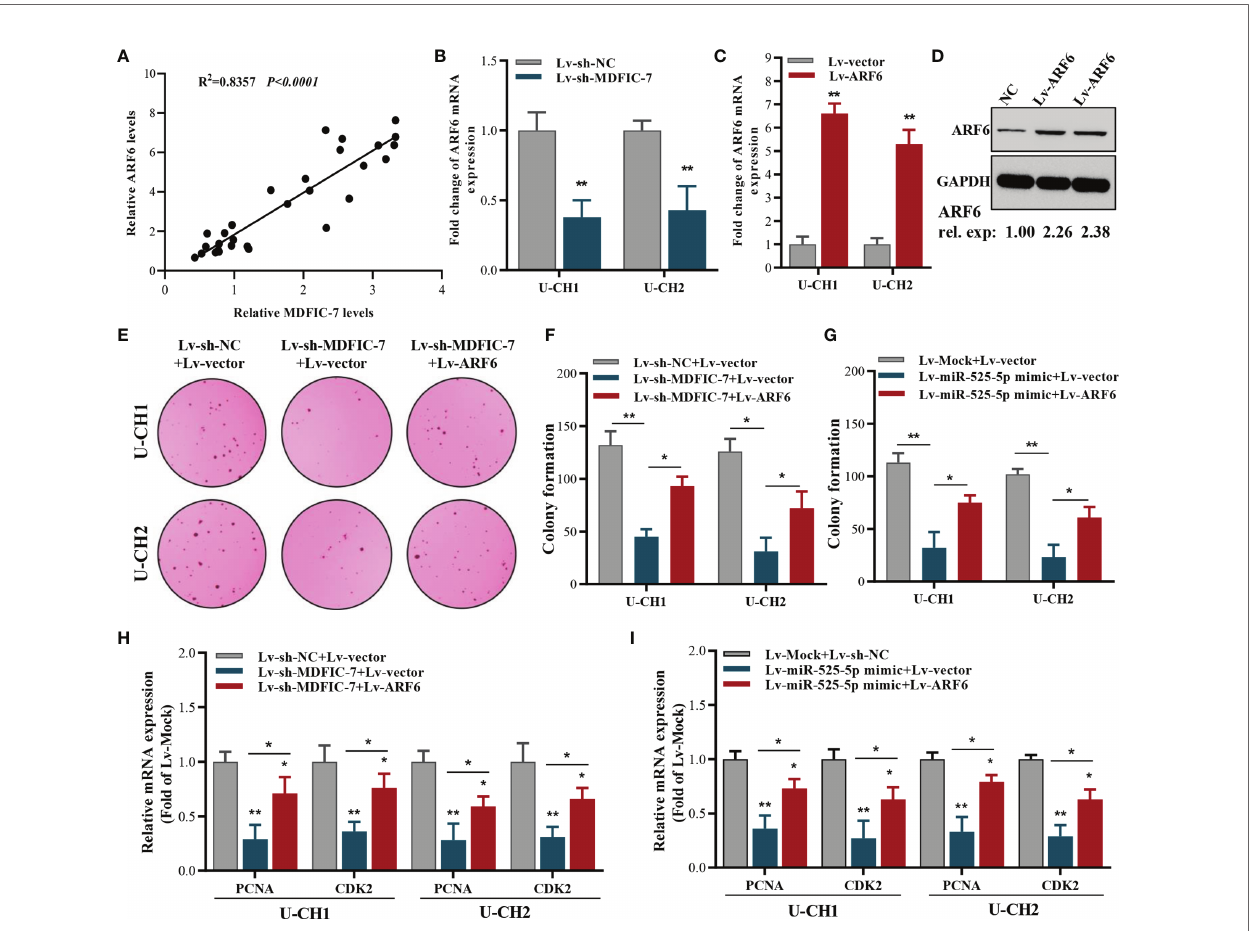
FIGURE 5 | ARF6 overexpression reverses the suppressive effect of lncRNA MDFIC-7 knockdown or miR-525-5p overexpression on cancer cell proliferation. (A) Correlation analysis between ARF6 and Ki-67 expression in tumor tissues and adjacent normal tissues of chordoma patients determined by qRT-PCR assay. (B) qRT-PCR analysis on ARF6 mRNA expression in cancer cells after lncRNA-MDFIC7 knockdown. (C, D) Effect of ARF6 mRNA and protein overexpression in U-CH1 and U-CH2 cells as detected by qRT-PCR and Western blot, respectively. (E, F) Colony formation assay in U-CH1 and U-CH2 cells after infection with Lv-sh-MDFIC-7 or co-infection with Lv-sh-MDFIC-7 and Lv-ARF6. * p < 0.05 vs . Lv-miR-lncRNA MDFIC-7+Lv-vector, ** p < 0.01 vs . Lv-mock+Lv-vector. (G) Colony formation assay in U-CH1 and U-CH2 cells after infection with Lv-miR525-5p or co-infection with Lv-miR525-5p and Lv-ARF6. * p < 0.05 vs . Lv-miR-525-5p+Lv-vector, ** p < 0.01 vs . Lv-mock+Lv-vector. (H) qRT-PCR analysis of PCNA and CDK2 mRNAs in U-CH1 and U-CH2 cells infected with Lv-MDFIC-7 or co-infected with Lv-MDFIC-7 and Lv-ARF6, * p < 0.05 vs . Lv-sh-MDFIC-7+Lv-vector, ** p < 0.01 vs . Lv-sh-NC+Lv-vector. (I) qRT-PCR analysis of PCNA and CDK2 mRNAs in U-CH1 and U-CH2 cells infected with Lv-miR-525-5P or co-infected with Lv-miR525-5p and Lv-ARF6, * p < 0.05 vs . Lv-miR525-5p+Lv-vector, ** p < 0.01 vs .